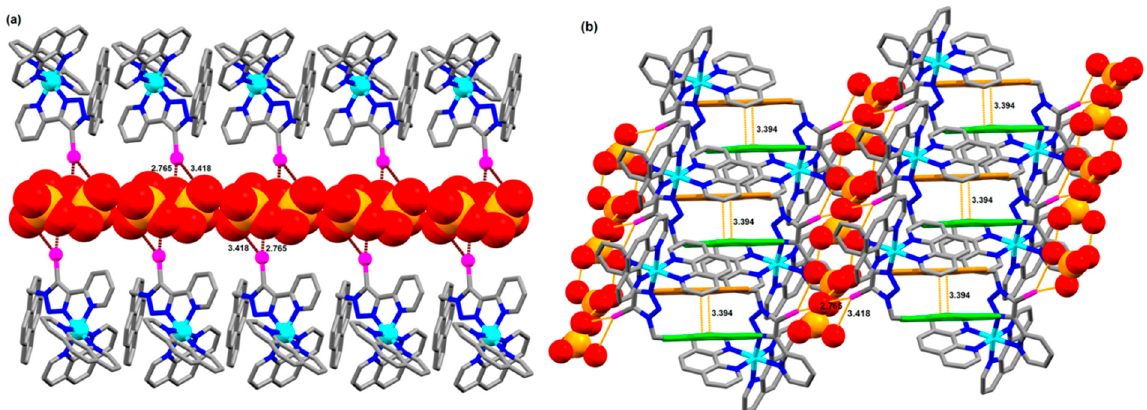
Figure 4. X-ray crystal structure of H 2 PO 4 − adduct of 13 where supramolecular polymeric chain propagated via ( a ) C-I···O interaction through halogen bond; ( b ) combined C-I···O and π - π stacking interactions. [Adapted from reference [57]; Copyright © 2023, American Chemical Society] .